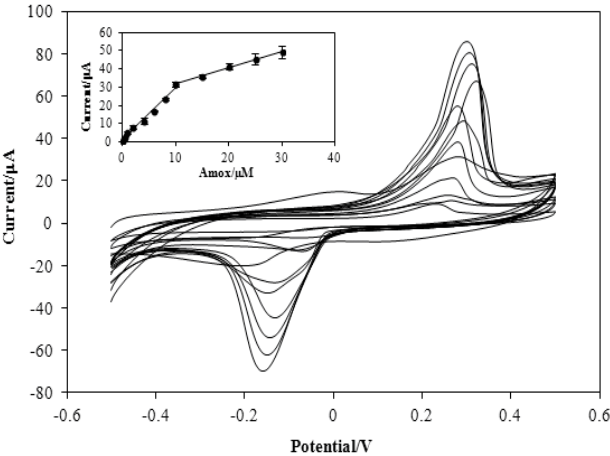
Figure 7. Adsorptive stripping response of different concentration of Amoxicillin at the modified